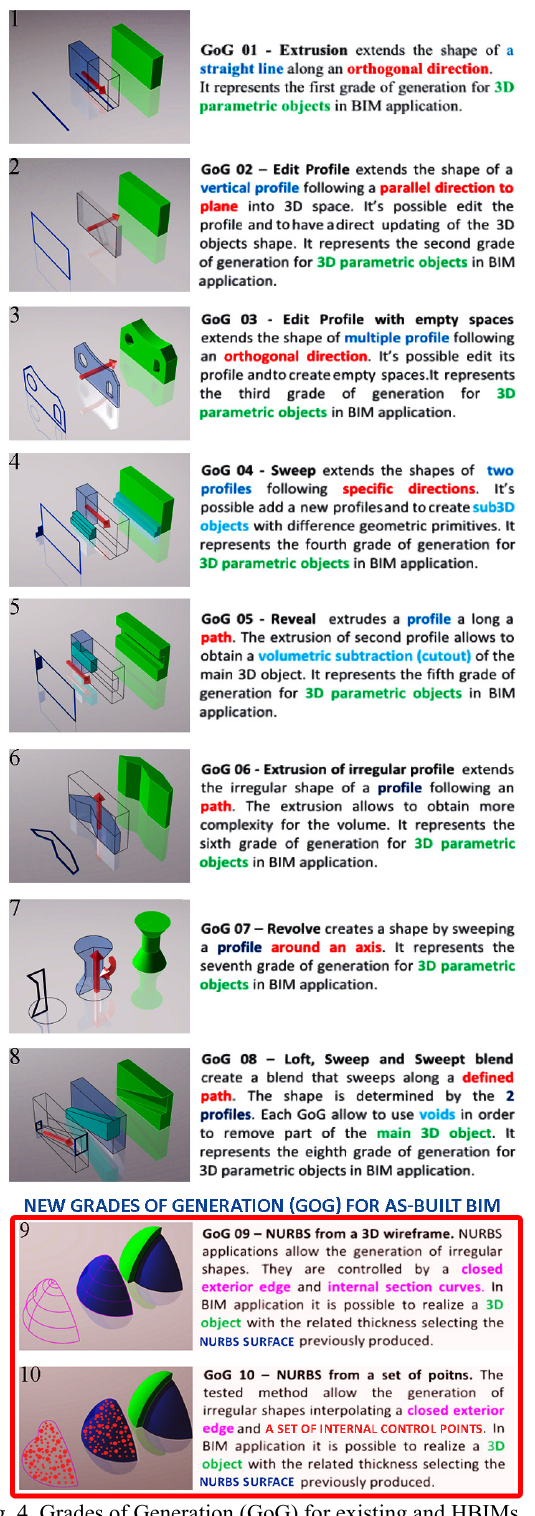
Fig. 4. Grades of Generation (GoG) for existing and HBIMs. The tested method has allowed the parametrization of complex 3D Object. BIM application needs GoG 9 and 10 in order to permit the automatic generation of complex 3D objects from point